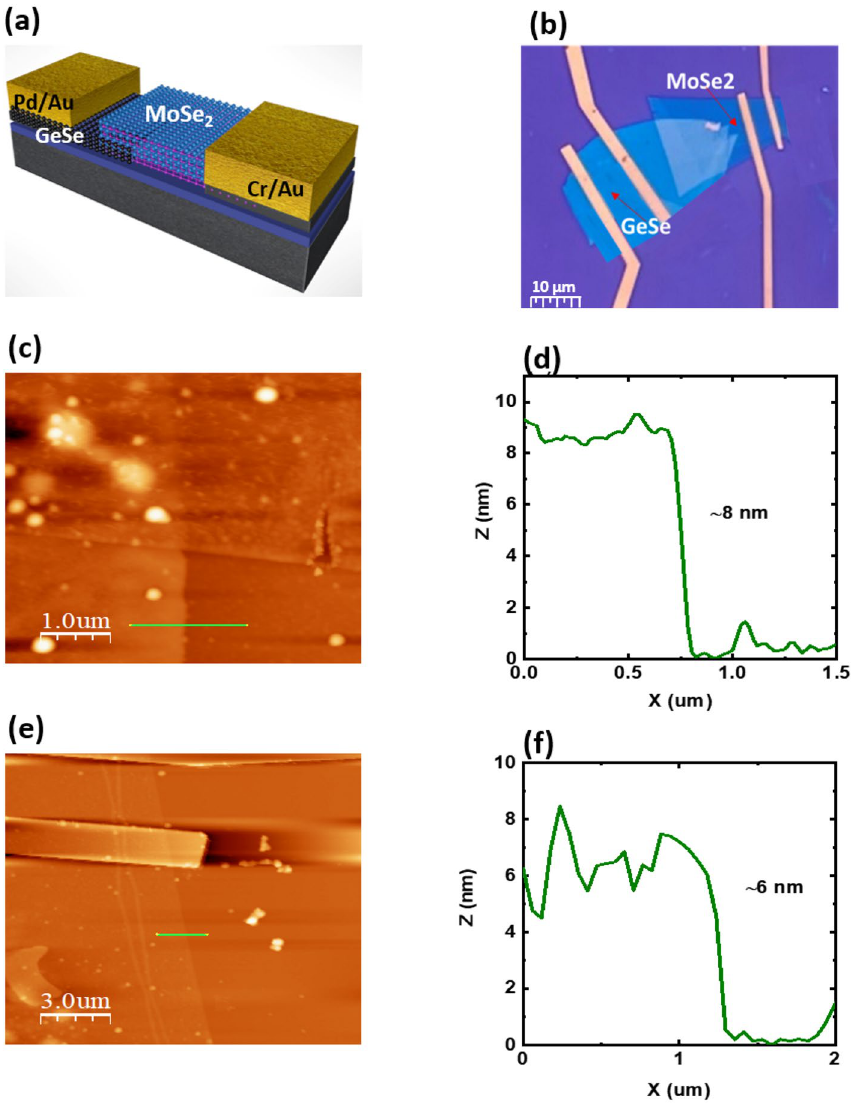
Figure 1. (a) A schematic view of the p-GeSe/n-MoSe 2 heterojunction diode. (b) The optical microscope image of the device. (c) An AFM image of the p-GeSe on the SiO 2 /Si substrate. (d) The height profile from the AFM. (e) An AFM image of n-MoSe 2 on the SiO 2 /Si substrate, and (f) their height